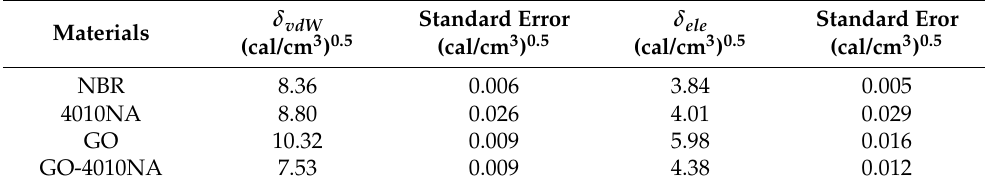
Table 3. Solubility parameters of NBR, 4010NA, GO, and GO-4010NA by MD simulation.